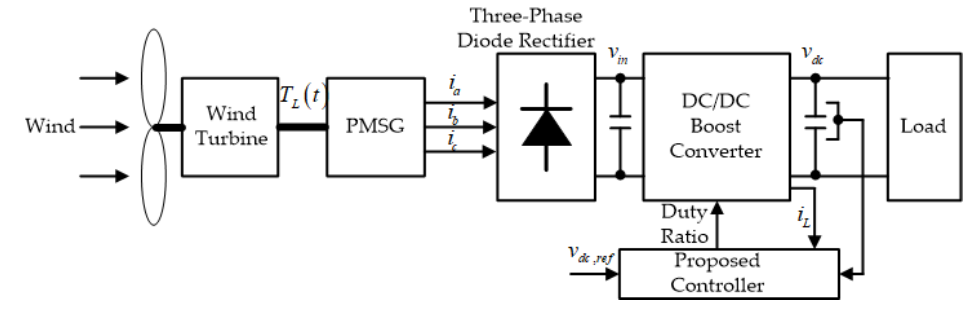
Figure 3. Wind power system configuration.